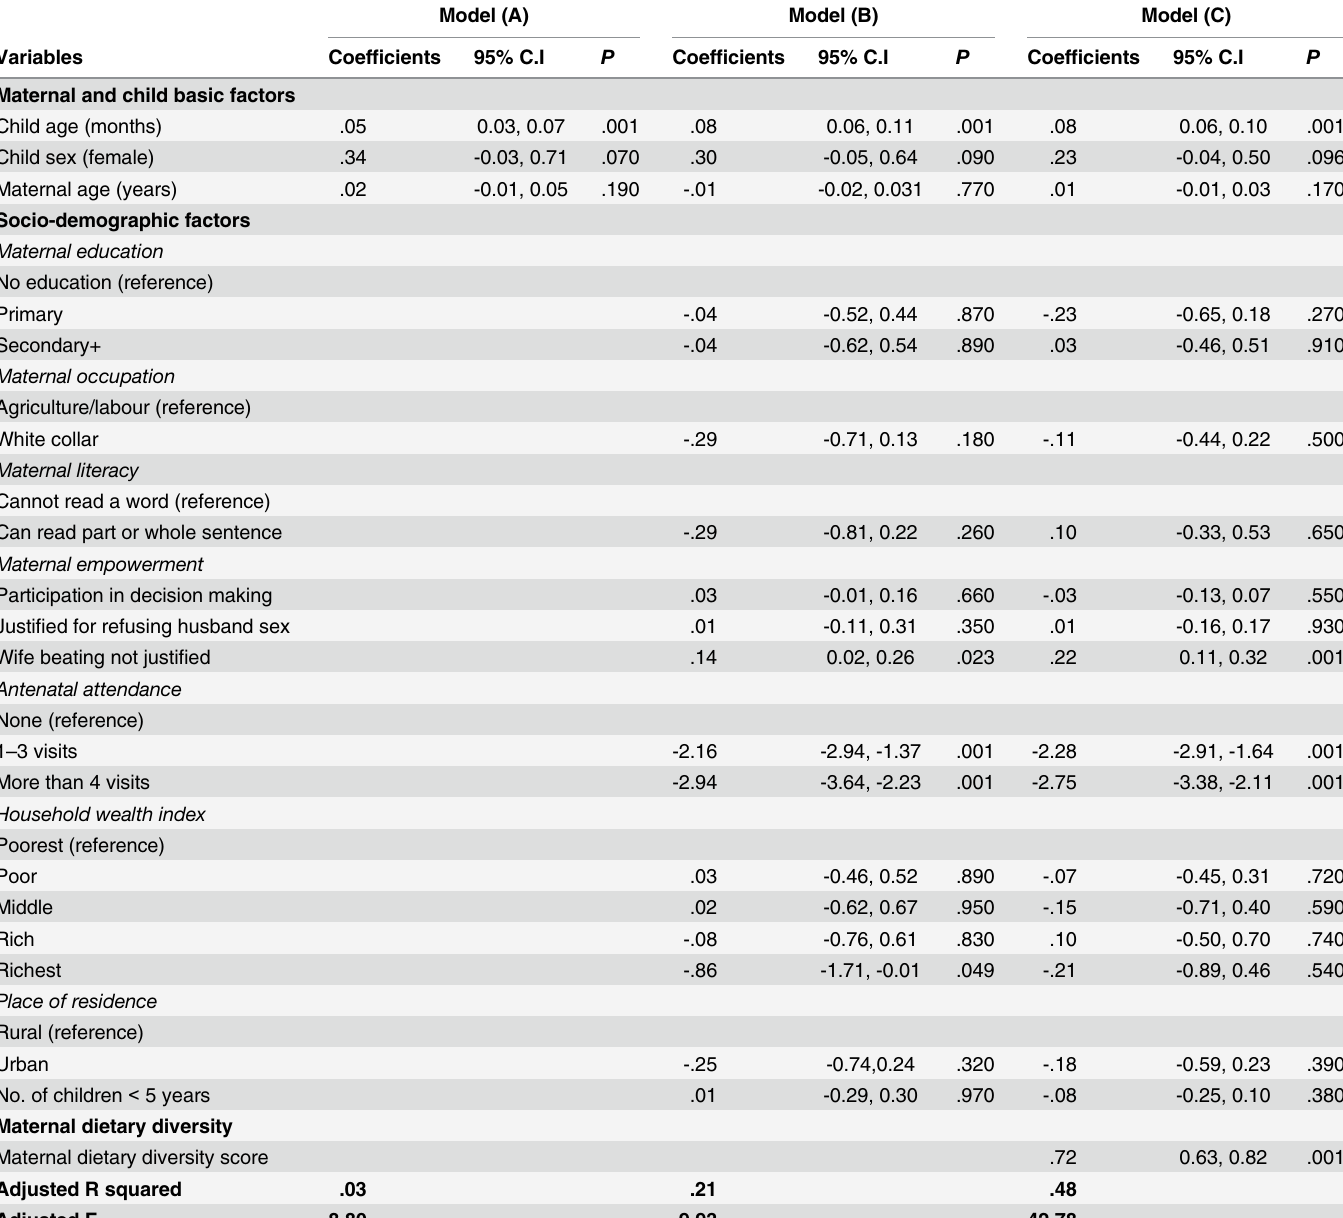
Table 4. Multiple linear regression analysis of the association between maternal and child